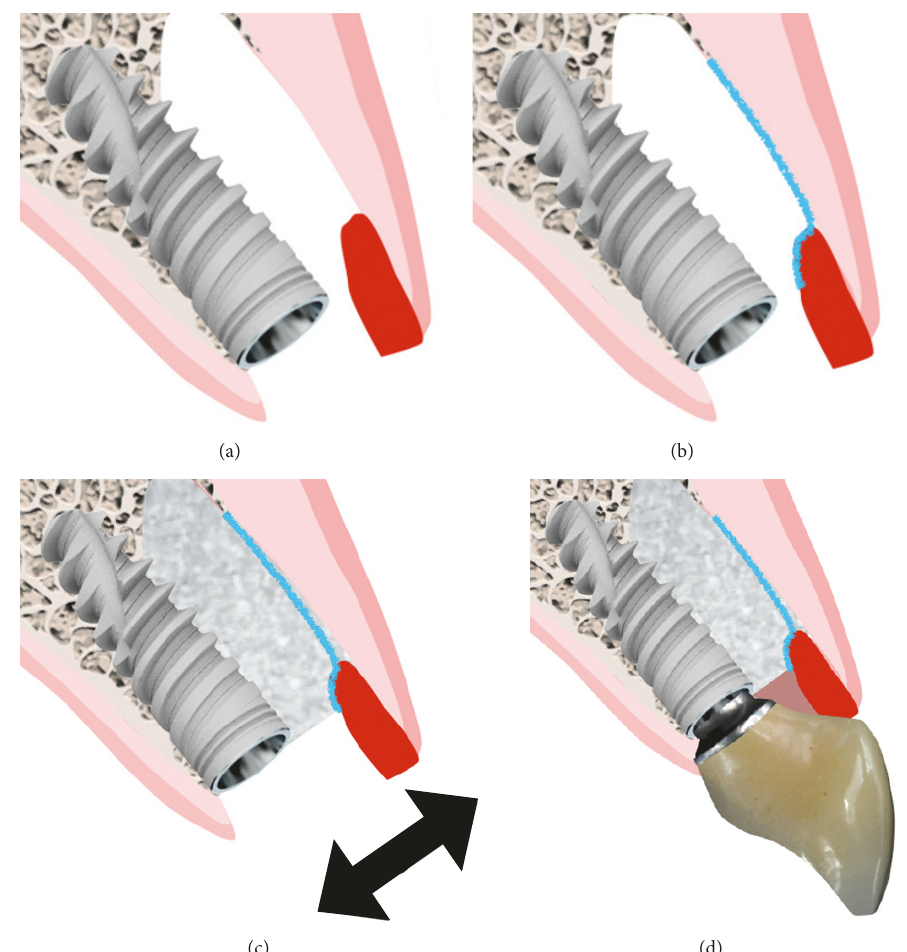
Figure 6: Lateral images demonstrating the sequence (a–d) of the reconstruction of the socket with the grafts and the immediate provisional.